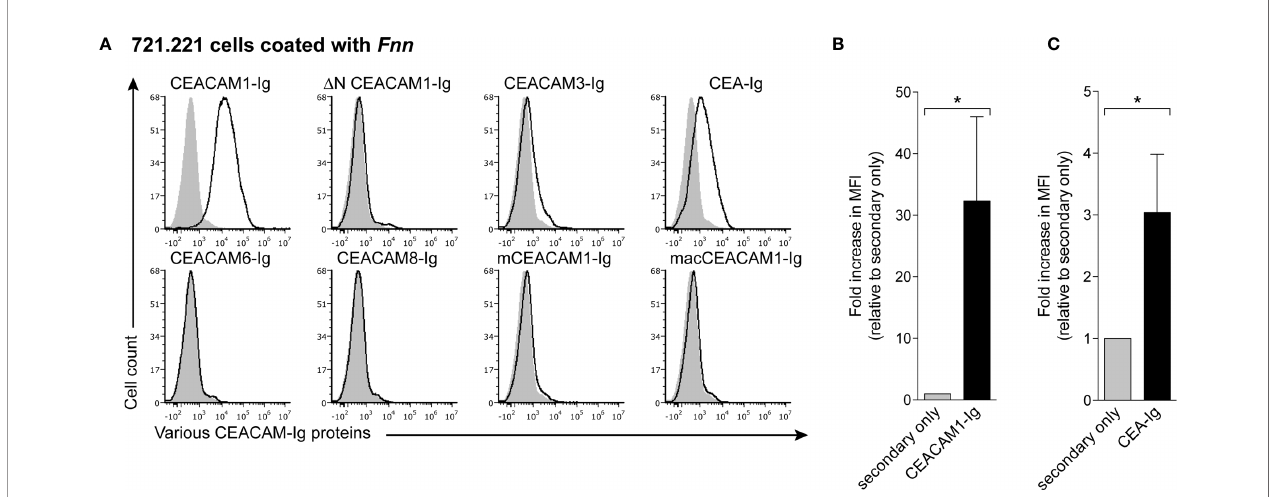
FIGURE 1 | Fnn speci fi cally binds to the N-terminal domain of human CEACAM1. (A) 721.221 cells coated with FITC-labeled Fnn were stained with 2 m g of human CEACAM1-Ig, Δ N CEACAM1-Ig that lacks the N-terminal domain, CEACAM3-Ig, CEA-Ig, CEACAM6-Ig, CEACAM8-Ig, mouse CEACAM1-Ig (mCEACAM1-Ig) or rhesus macaque CEACAM1-Ig (macCEACAM1-Ig). Filled grey histograms represent staining with secondary antibody only. Representative histograms from three independent repeats are shown. (B) CEACAM1-Ig and (C) CEA-Ig staining quanti fi ed and shown as fold increase in MFI relative to secondary only. Bars represent means of three independent experiments ± SD. Statistical signi fi cance was assessed using a two-tailed unpaired t test. *p ≤